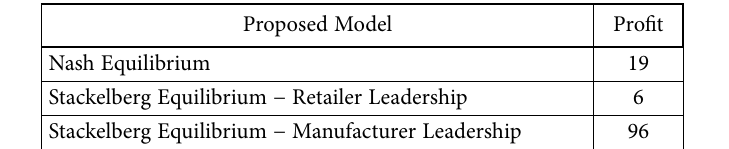
Table 13. Profit of different